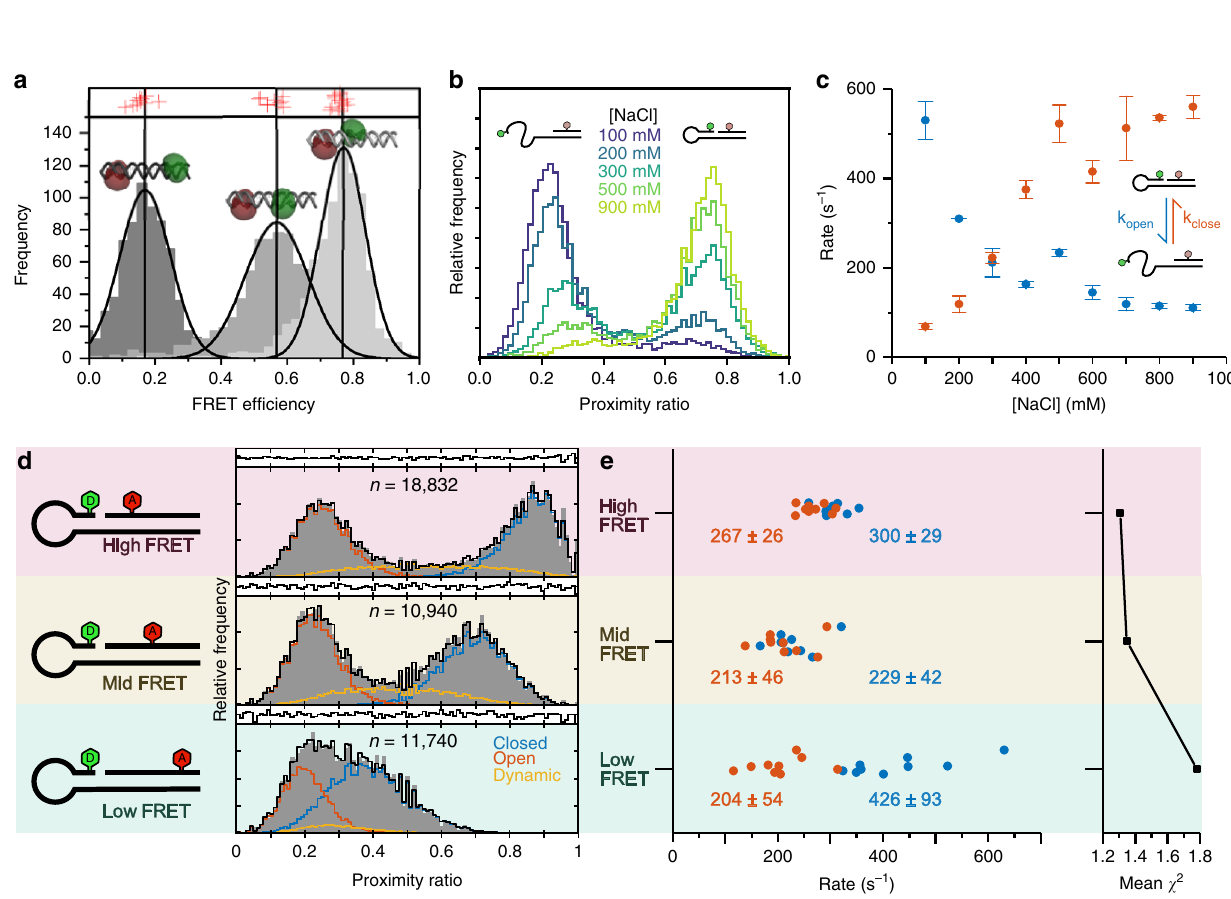
Fig. 2 Experiments validating the smfBox. a Fully corrected FRET ef fi ciency histograms of three doubly labelled DNA standards (1a, 1b and 1c, cartoons with dye accessible volumes; for sequences see Supplementary Note 5) measured using the smfBox (grey). Vertical black lines and curves show Gaussian fi ts of our data, E = 0.17 ± 0.07, E = 0.57 ± 0.1, E = 0.77 ± 0.07 (mean ± sd), compared to the results from 20 other labs as part of a multi-lab benchmarking study 5 (red crosses — Supplementary Note 6). b Proximity ratio (uncorrected FRET ef fi ciency) histograms of a DNA hairpin at indicated salt concentrations (see Supplementary Note 5). c Salt dependent rates for hairpin opening ( k open ) and closing ( k close ) determined by dynamic photon le. d Proximity ratio histograms of High-, Mid- and Low-FRET hairpins (at 300 mM NaCl). Data (grey) were fi t using dPDA (black) to a two-state model, comprising a closed population (blue), open population (orange) and interconverting dynamic population (yellow). e Plot of rates determined from dPDA of nine data sets for each hairpin, each containing 2000 molecules, quoting the mean and standard deviation across the data sets, with the mean chi-squared of the fi ts plotted to the